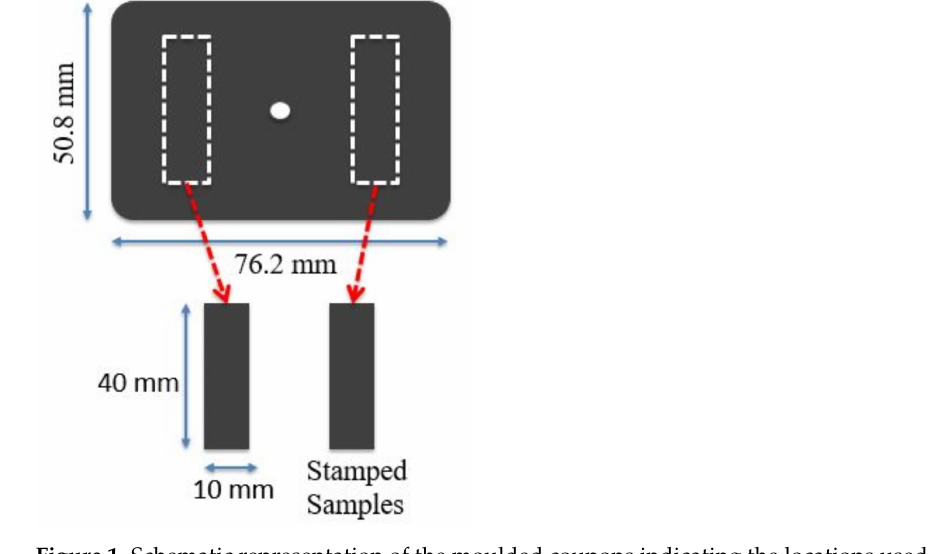
Figure 1. Schematic representation of the moulded coupons indicating the locations used to create stamped sample